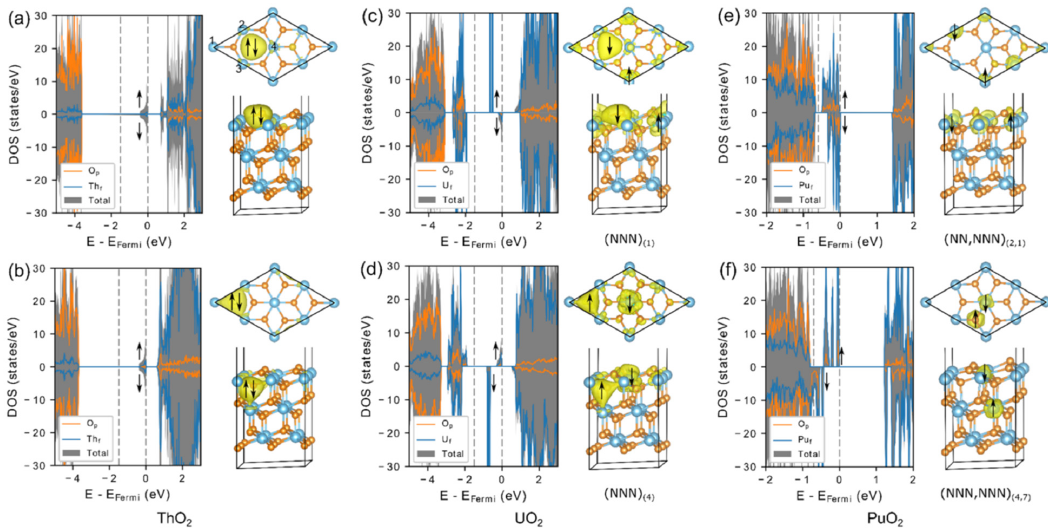
Figure 5. Density of states (DOS) and partial charge density plots of reduced ThO 2 , UO 2 , and PuO 2 (111) surfaces with oxygen vacancy in the top-surface ( a, c, e ) and in the subsurface ( b, d, f ) [55].